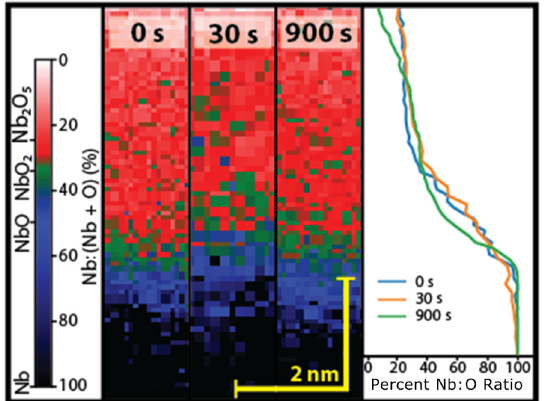
FIG. 16. STEM-EELS data on the niobium oxide MA inter- face, confirming the variation of the oxide composition with depth. (a) Niobium oxide Nb:(Nb + O) EELS maps as a func- tion of the etch time, showing the spatial distribution of the oxide phases. The morphology of the niobium oxide-metal inter- face does not change significantly even with extended etching. (b) Depth profiles derived from EELS spectra.